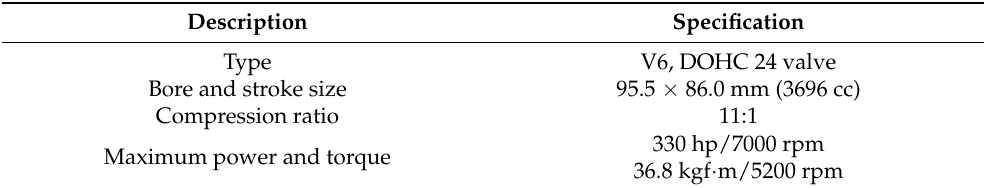
Figure 2. Schematic diagram of the experimental procedure. ( A ) Exhaust system design and proto- typing; ( B ) back-pressure and vibration measurement settings; ( C ) back-pressure and vibration measurement; ( D ) analysis of measured results. Table 1. Specifications of the V6 engine of the vehicle used in the experiment.